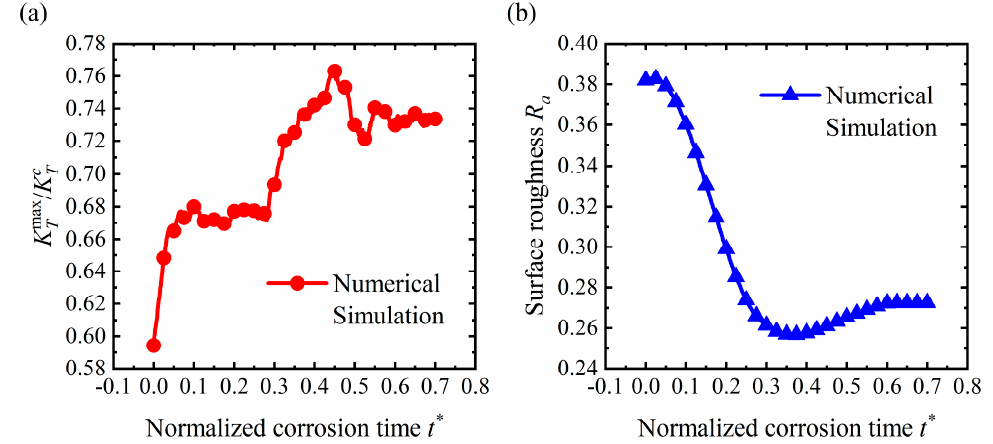
Figure 18. Evolution of ( a ) maximal stress concentration factor and ( b ) surface roughness during corrosion when A ∗ = 0.6 and σ A = 30